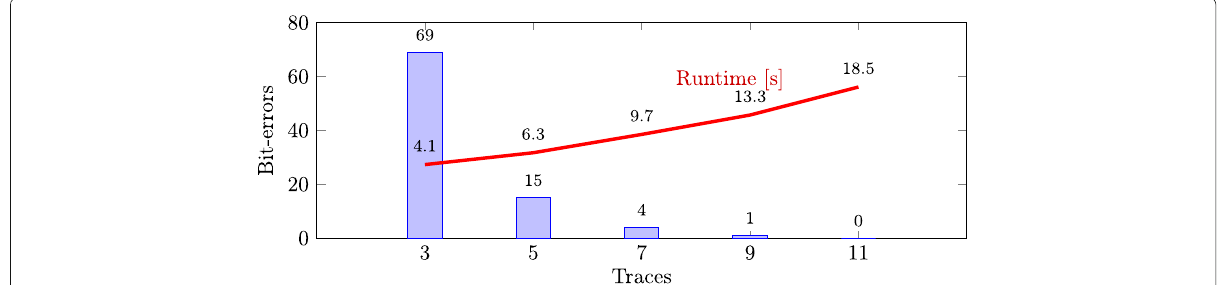
Fig. 11 With the number of captured traces, the number of bit errors decreases while the runtime to recover the key